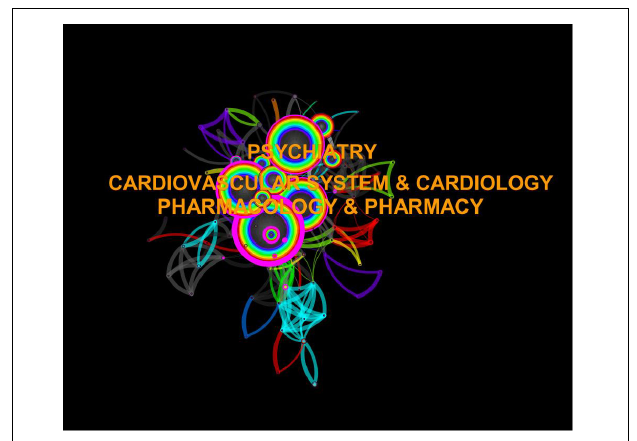
FIGURE 6 | Category network